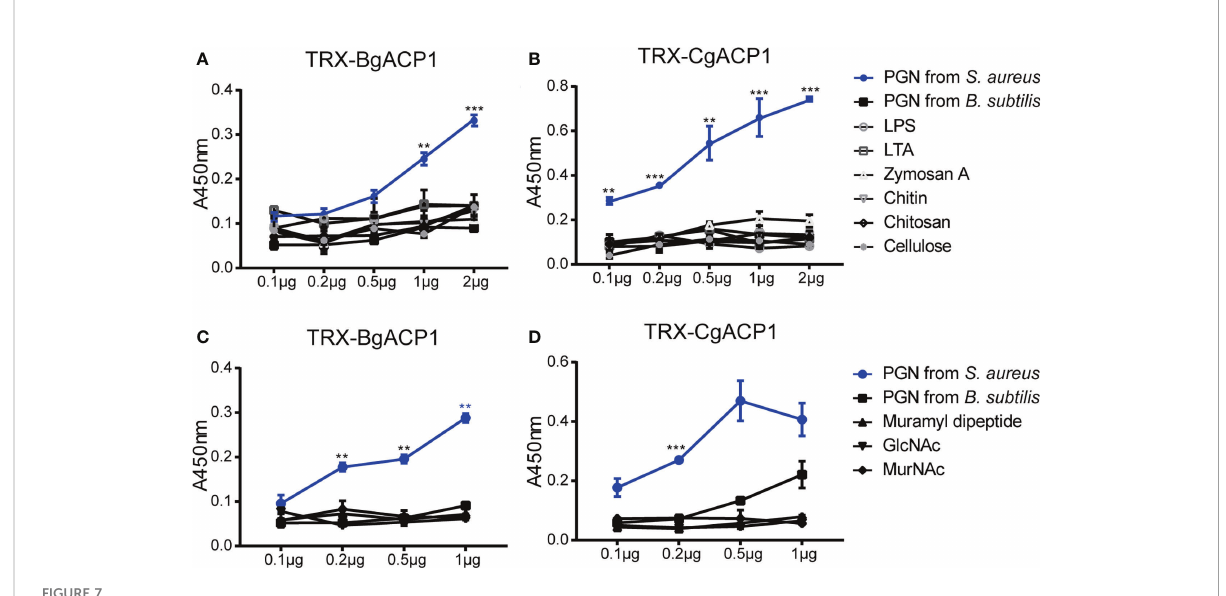
FIGURE 7 The carbohydrate-binding speci fi city and af fi nity of recombinant CgACP1 and BgACP1. (A, B) ELISA assays of the interaction between recombinant fusion TRX-CgACP1 and TRX-BgACP1 to different bacterial cell wall components. (C, D) ELISA assays of the interaction between recombinant fusion ACPs and several moieties of PGN. GlcNAc, N-acetylglucosamine; MurNAc, N-acetylmuramic acid. ** p < 0.01, *** p < 0.001. Three biological replicates were conducted for each experiment, and three technical replicates were performed. One of the representative results was shown